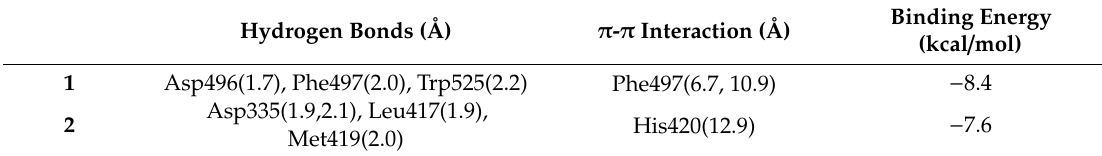
Table 2. Interaction and binding energy of sEH with flavonoids ( 1 and 2